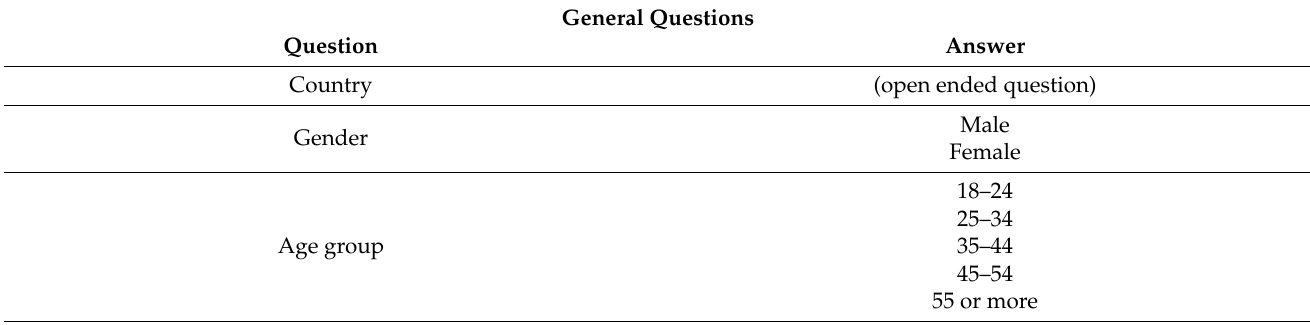
Table 5. Sample survey questions and